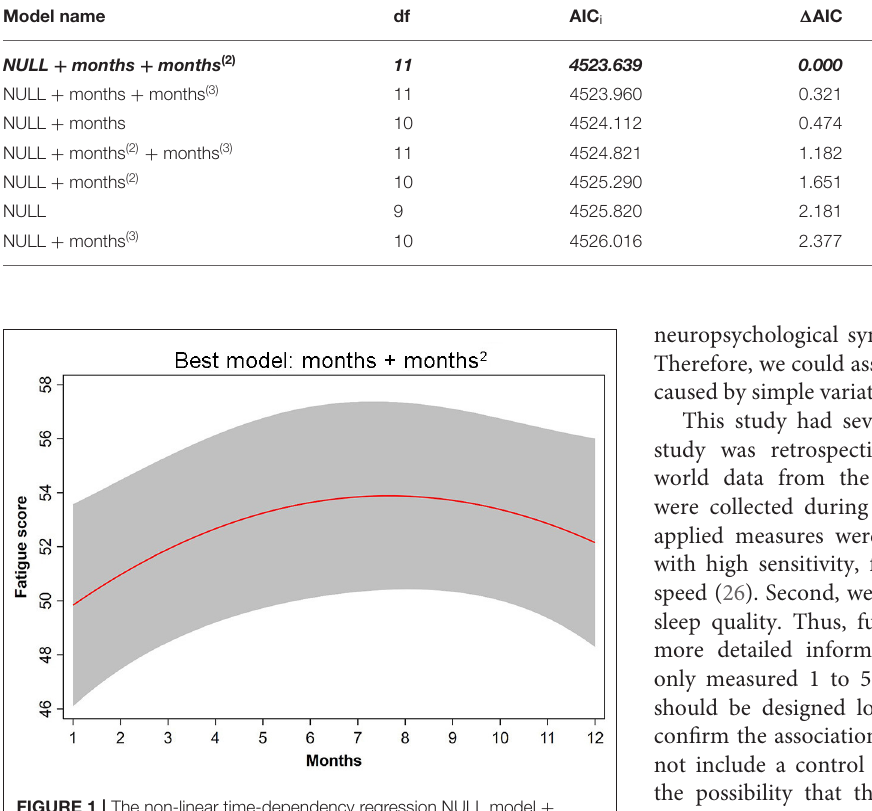
FIGURE 1 | The non-linear time-dependency regression NULL model + months + months 2 provided the best fit to the fatigue data.